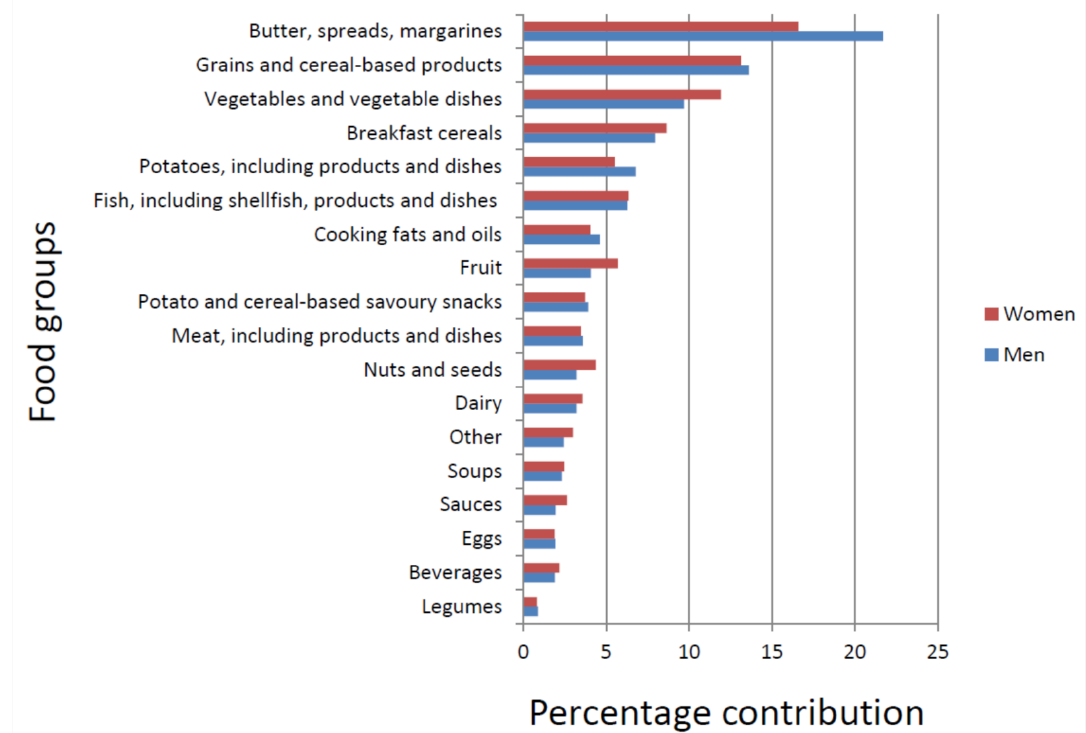
Figure 2. Percentage composition of food groups for vitamin E intake of men and women in the EPIC-Norfolk